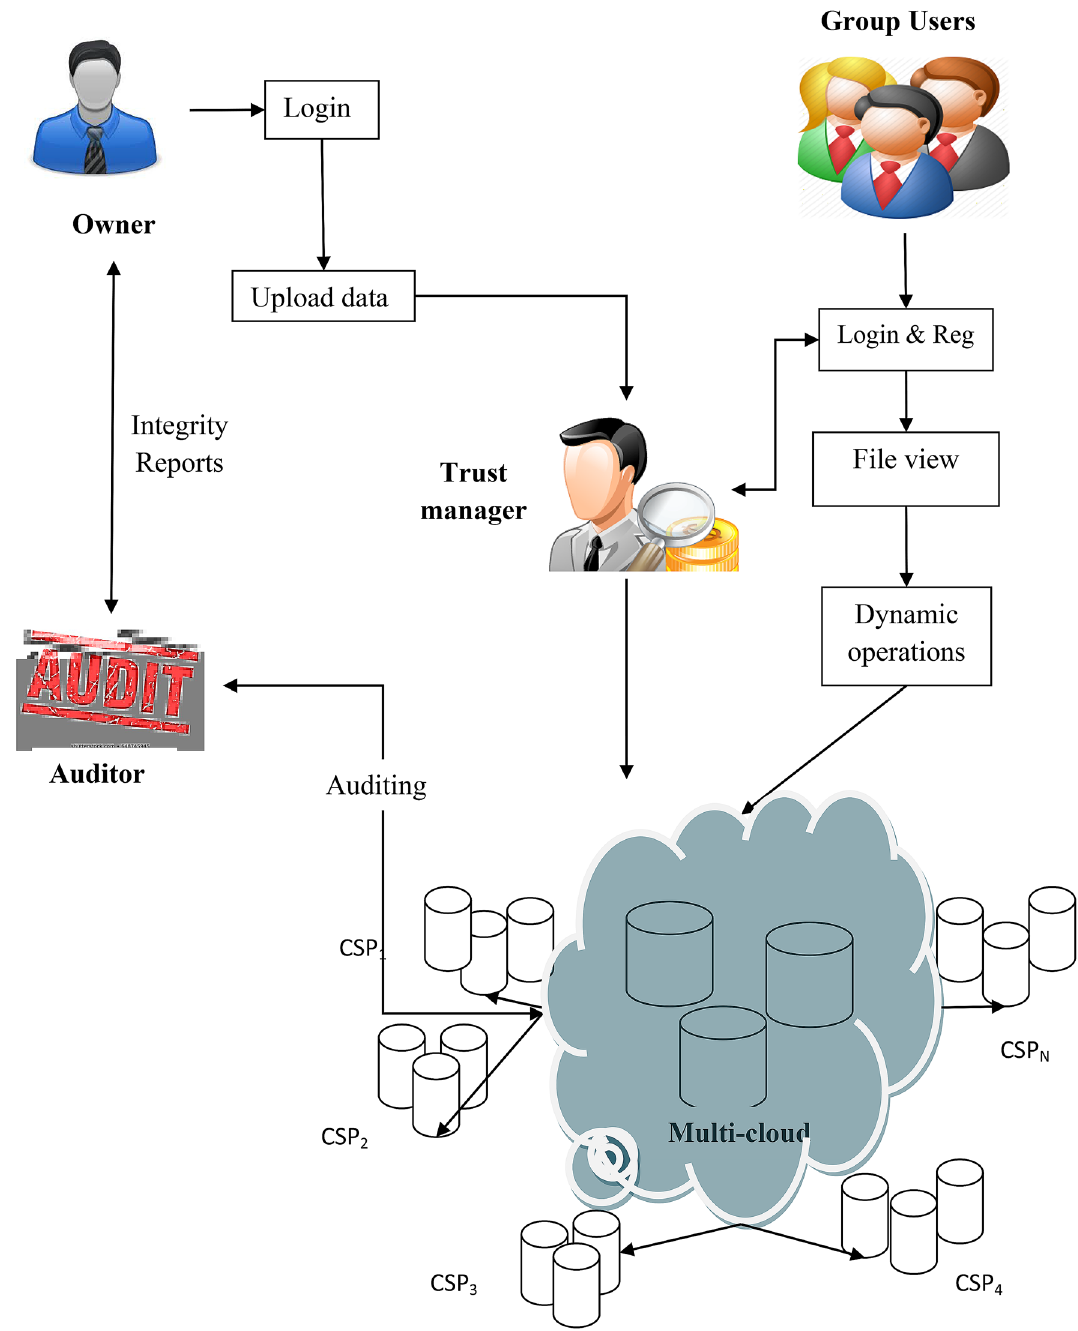
Figure 2. Architecture of data integrity checking